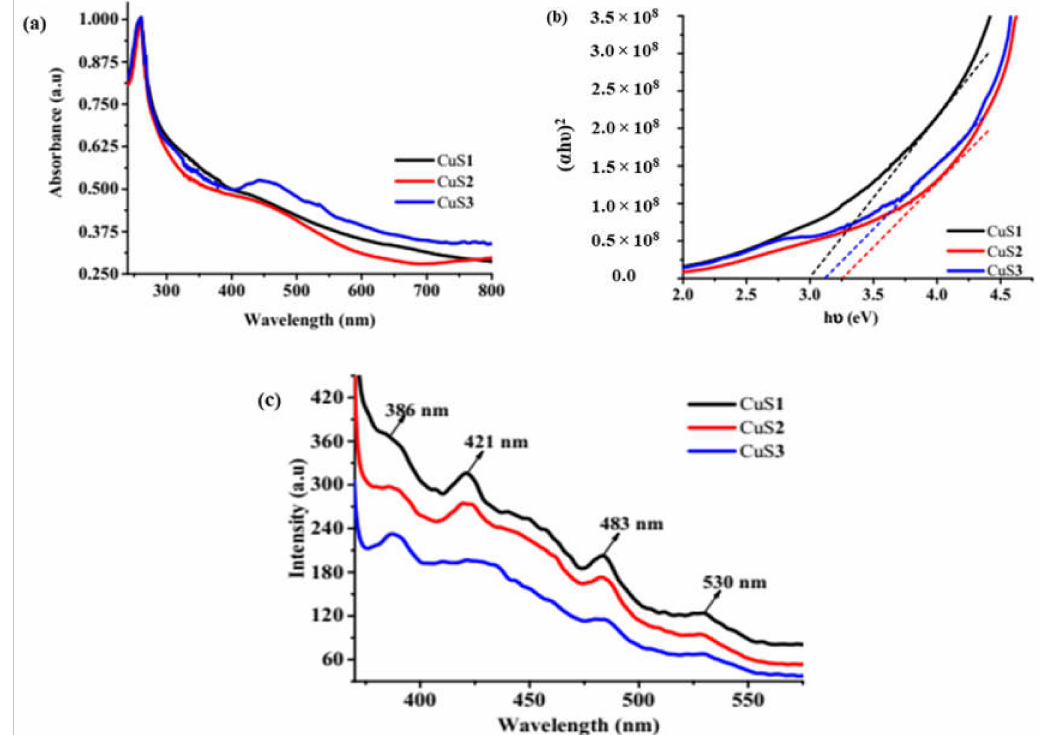
Figure 3. Ultraviolet-visible absorption spectra ( a ) Tauc’s plot ( b ) and photoluminescence spectra ( c ) of as-prepared CuS